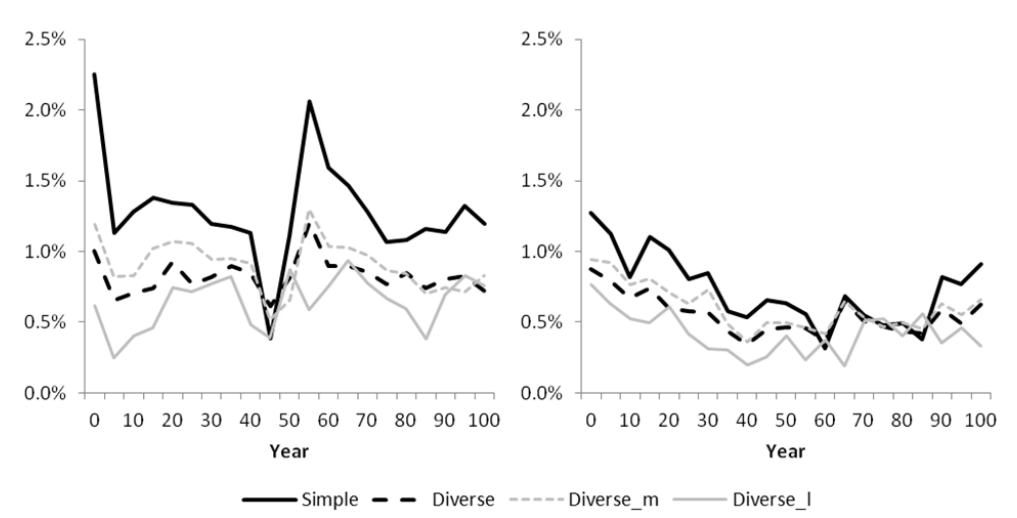
Figure 12. Proportion of annual clear-cut area (excluding regeneration areas with seed or shelter tree retention) in Hässleholm ( left ) and Vilhelmina ( right ), for the Simple and Diverse scenarios, as well as the more intensive (Diverse_m) and less intensive (Diverse_l) variations of the Diverse